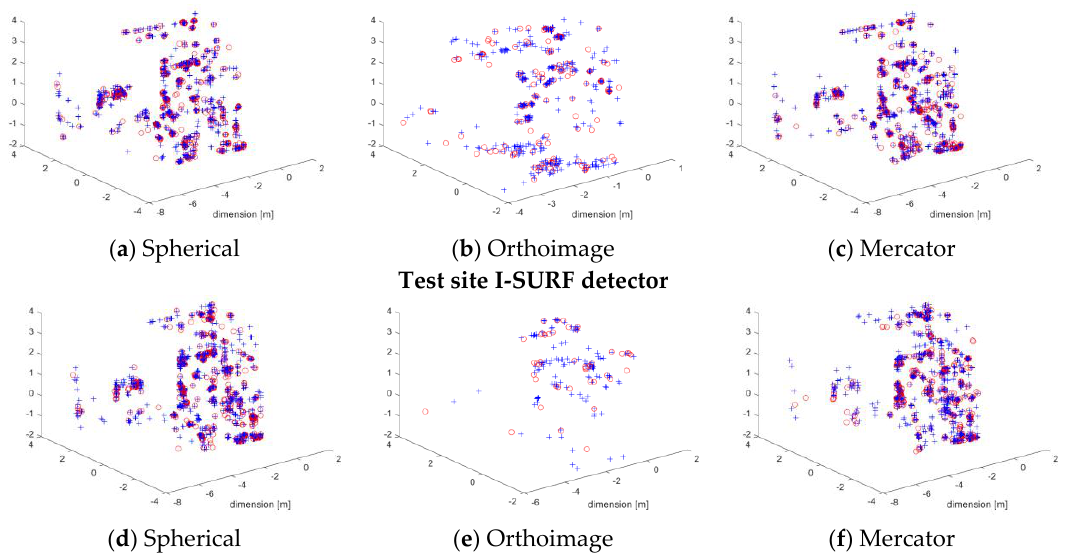
Figure A.3. Distribution of points used in the TLS data orientation process for the pair of scans for the scanner stations for test sites III : “The office room” -the best distribution of the control (blue) and check points (red). Points detected by FAST ( a – c ) and SURF ( d – f ) detectors on raster images: ( a/d ) in the spherical projections, ( b/e ) in the orthoimage and ( c/f ) in the Mercator projection.